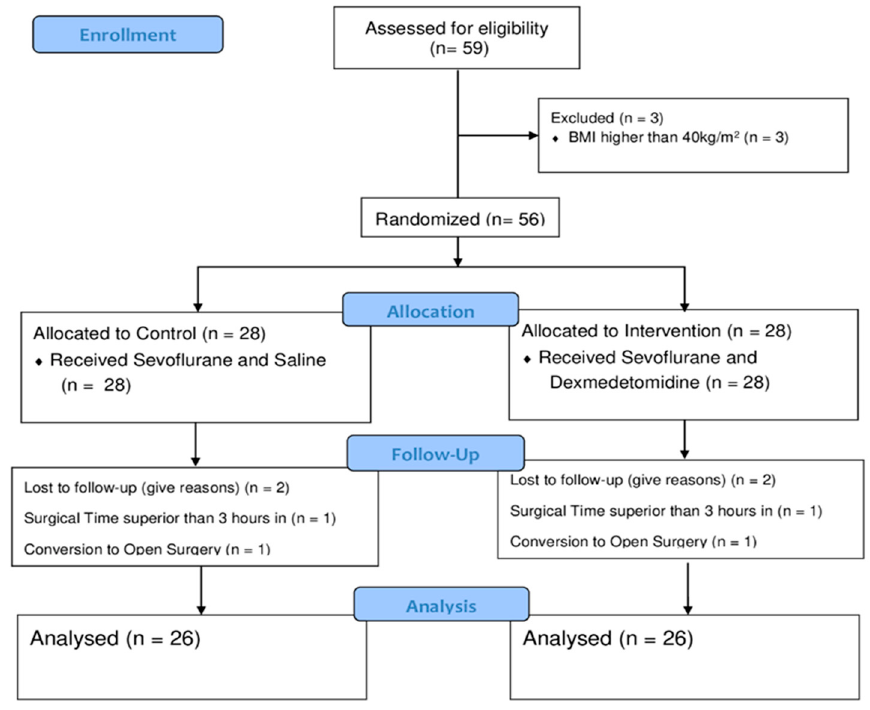
Figure 1. Consort flow Figure 1. consort flow diagram.